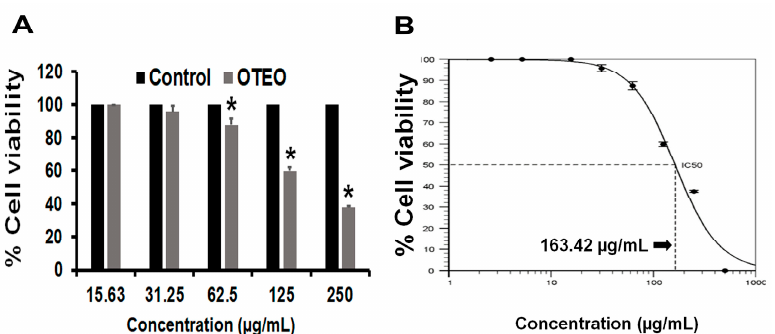
Figure 1. ( A ) Percentage of viable AGS cells after treatment with OTEO for 24 h, as measured by MTT assay. ( B ) Dose-response curve and IC 50 value of OTEO in the AGS cell line determined using AAT Bioquest IC 50 calculator. Data are represented as mean ± SD from triplicate independent experiments. * p -values less than 0.05 considered significant when compared with control.